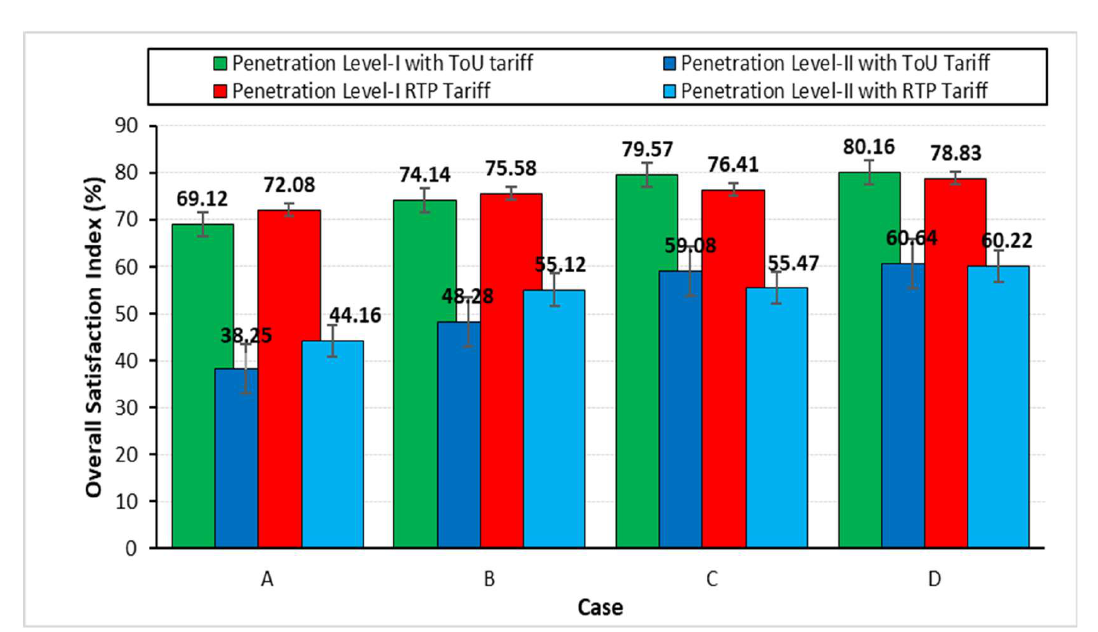
Figure 16. Comparison of overall charging satisfaction index .